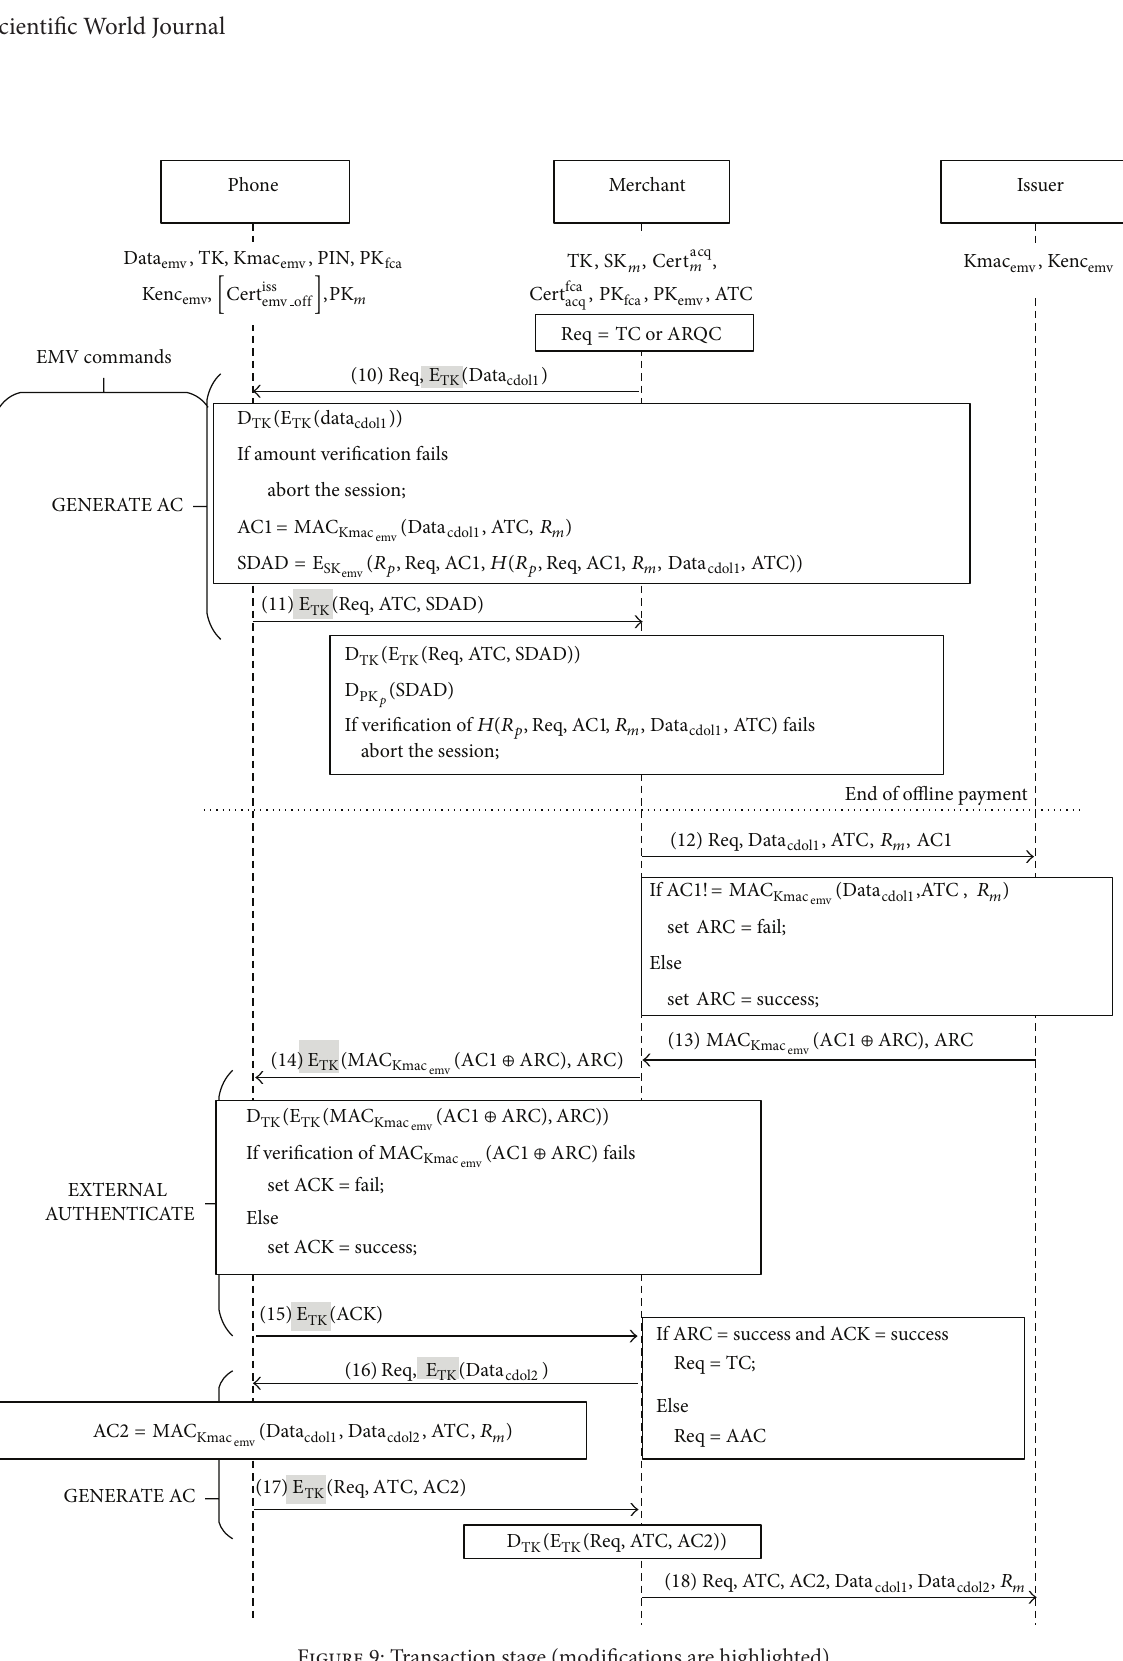
Figure 9: Transaction stage (modifications are